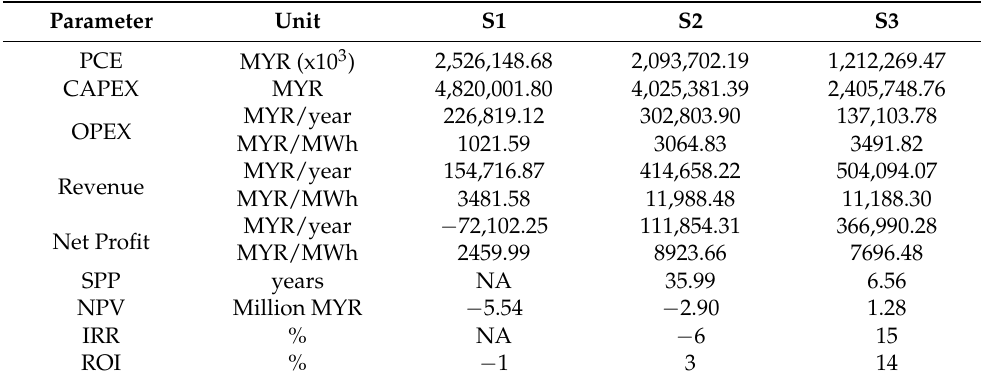
Table 4. Summary of Economic Parameters calculated for each